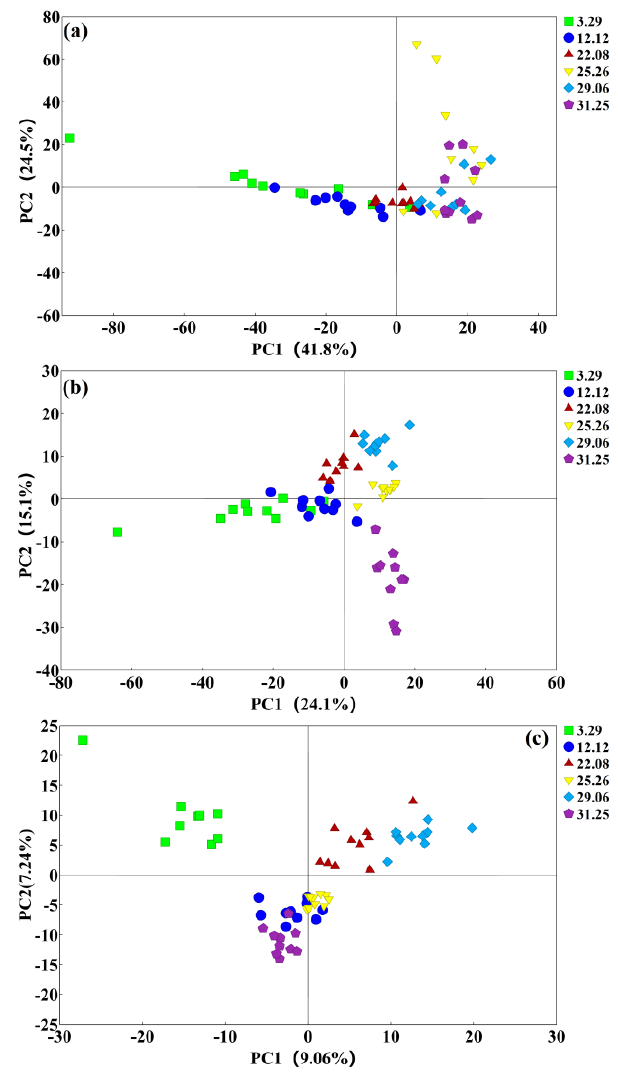
Figure 2. Principal component analysis (PCA) dimensionality reduction projection plots of the smoothed and baseline corrected spectra ( a ), first derivative treated spectra ( b ), and second derivative treated spectra ( c ).